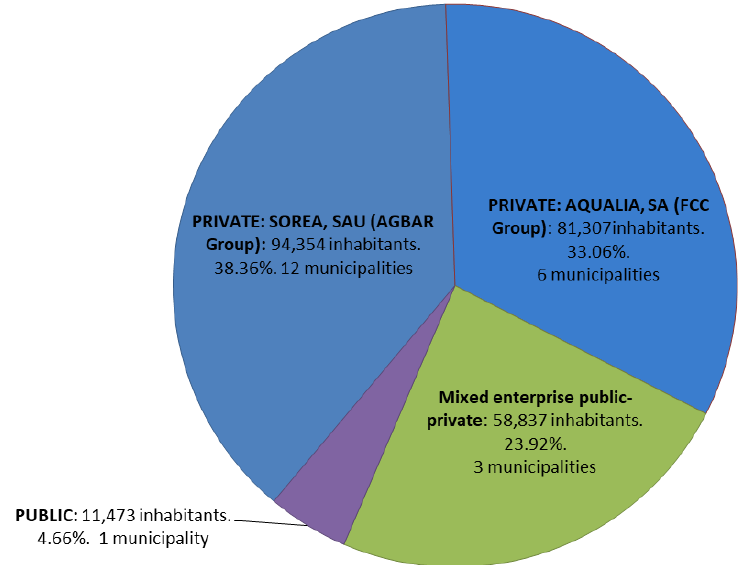
Figure 2. Distribution of ownership of drinking water supply companies in the littoral municipalities in Costa Brava (2014). Source: authors’ own data.